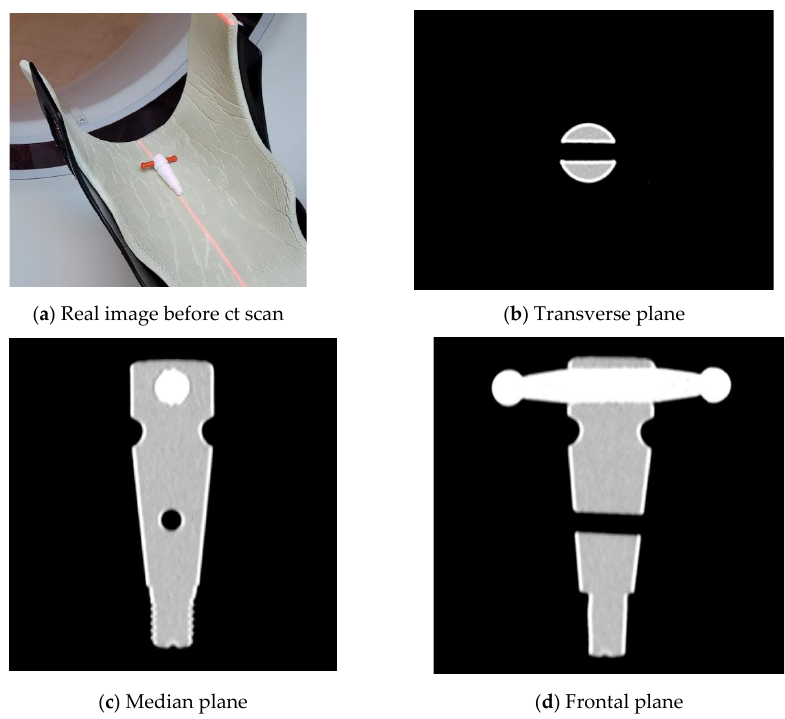
Figure 8. ( a ) The T-shaped bar placed on the CT examination table before scan. ( b – d ) The recon- structed CT images of the transverse plane, median plane, and frontal plane, respectively, for the T-shaped bar. Because CT has high resolution, it is possible to distinguish the difference in density, so even the detailed structure of the T-shaped bar can be seen.